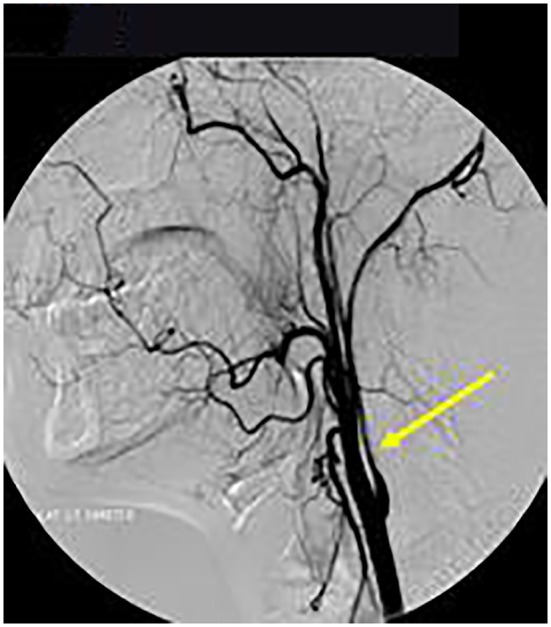
Formal Catheter Angiography: Sagittal views following left carotid injection showed ≥75% extracranial LICA stenosis (arrow). LICA was occluded in the supraclinoid segment after the left ophthalmic artery origin with moyamoya phenomenon (not shown).